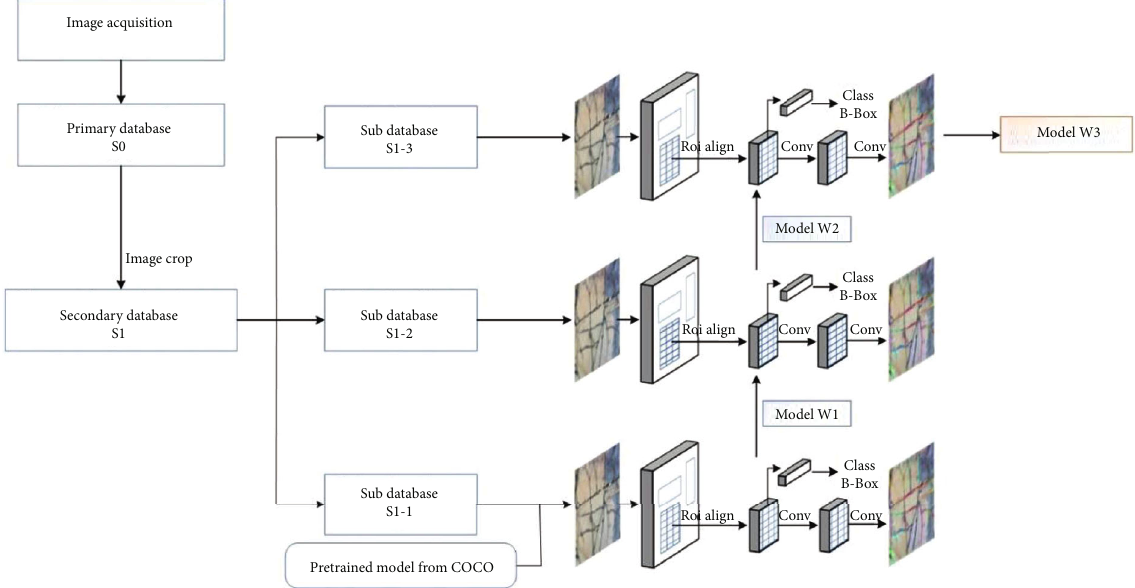
Figure 5: Operation schematic diagram of crack detection (the training of model weight W1 to W3 is contributed by the same framework of multi-CrackNet).